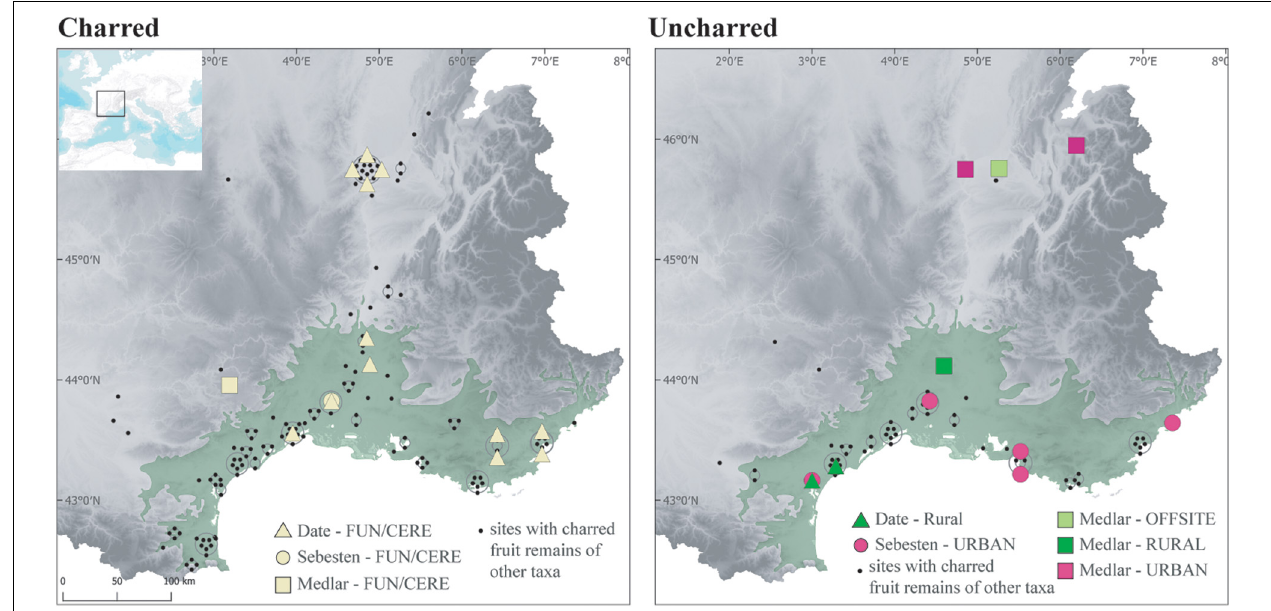
FIGURE 10 | Maps showing the distribution of the records of date ( Phoenix dactylifera ), sebesten ( Cordia myxa ) and medlar ( Mespilus germanica ) in Roman sites according to preservation and site